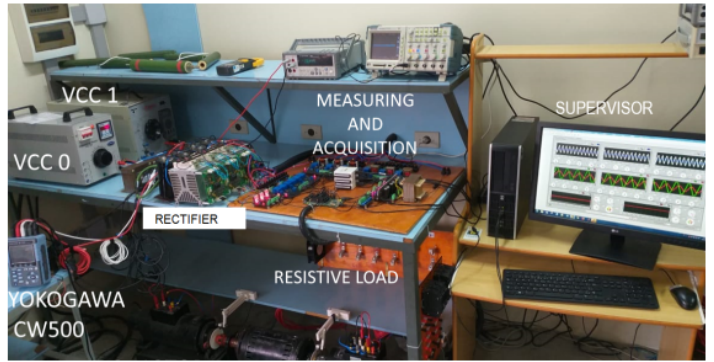
Figure 24. DC-link voltage V 0 (300 V/div) and phase currents i a , i b and i c (14 A/div), V ∗ V grms = 110 V. Hor 100 ms/div.